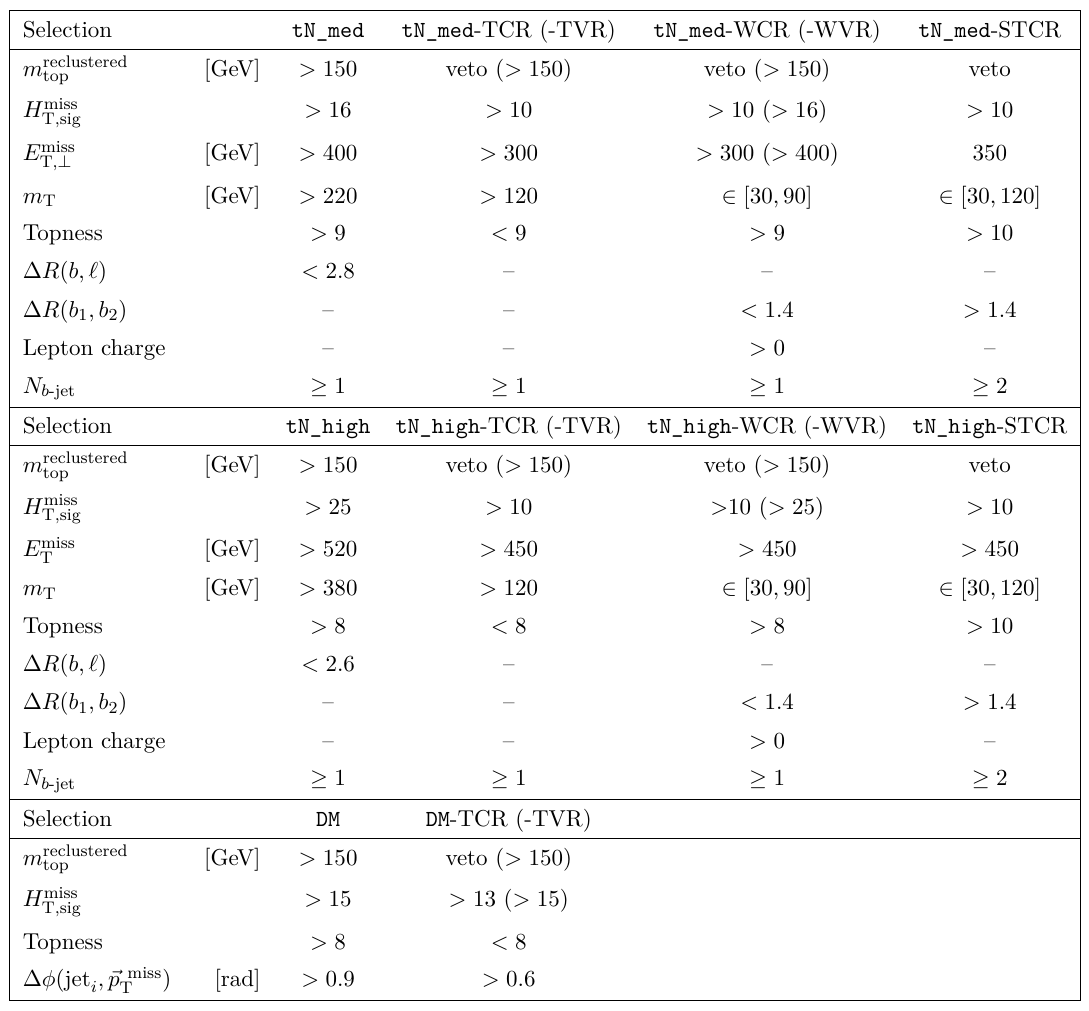
Table 10. Event selections defining the CRs and VRs in tN_med , tN_high and DM relative to their respective signal regions. Only variables for which the selection criteria in the CRs or VRs differ from those in the SRs are